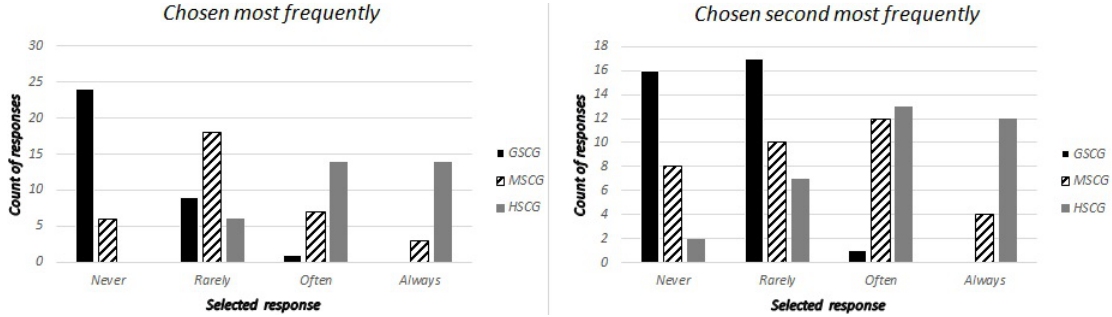
Figure 4. Expert predictions for question 4: "Chosen most" and "Chosen second most" frequently.